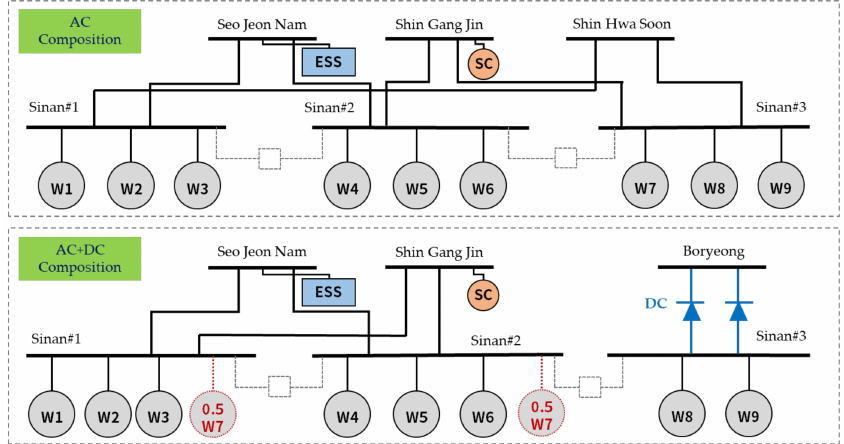
Figure 5. System diagram according to interconnection measures and interconnection